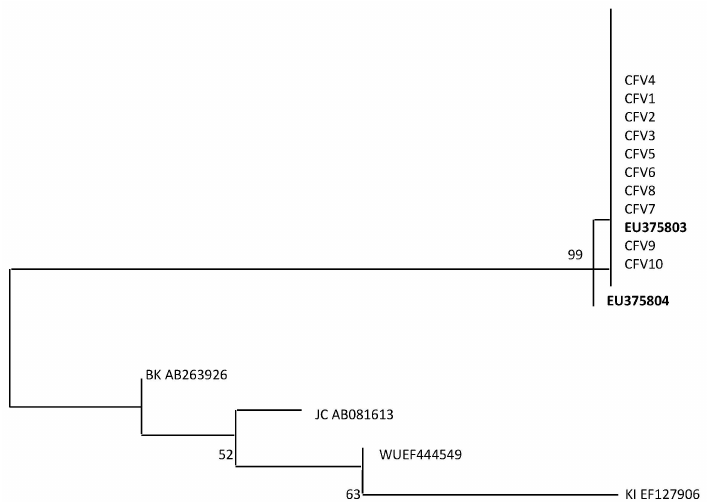
Figure 3. Phylogenetic analysis of nucleotide sequences of MCPyV VP1 from 10 CF representative oropharyngeal aspirate samples. Phylogenetic tree including the VP1 sequences CFV (1 to 10). The phylogenetic tree has been generated by retrieving two MCPyV reference strain sequences deposited in Genbank (NCBI) under the following accession numbers: EU375803 and EU375804. Moreover, the analysis includes representative BKPyV, JCPyV, KIPyV, and WUPyV sequences from GenBank. The phylogenetic tree was generated using Mega 6.0 software using the neighbor joining algorithm. Bar, 0.02 substitutions per